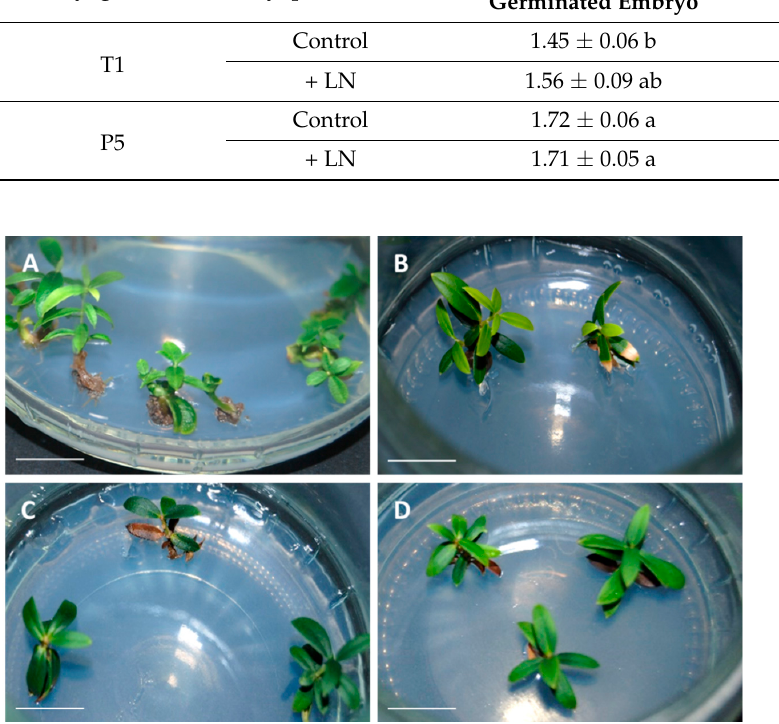
Table 1. Effect of cryopreservation on the regeneration quality of control and cryopreserved em- bryogenic cultures of the lines T1 and P5. Data represent the mean ± SEM. Different letters indicate significant differences by the LSD test, with a significance level of 0.05.